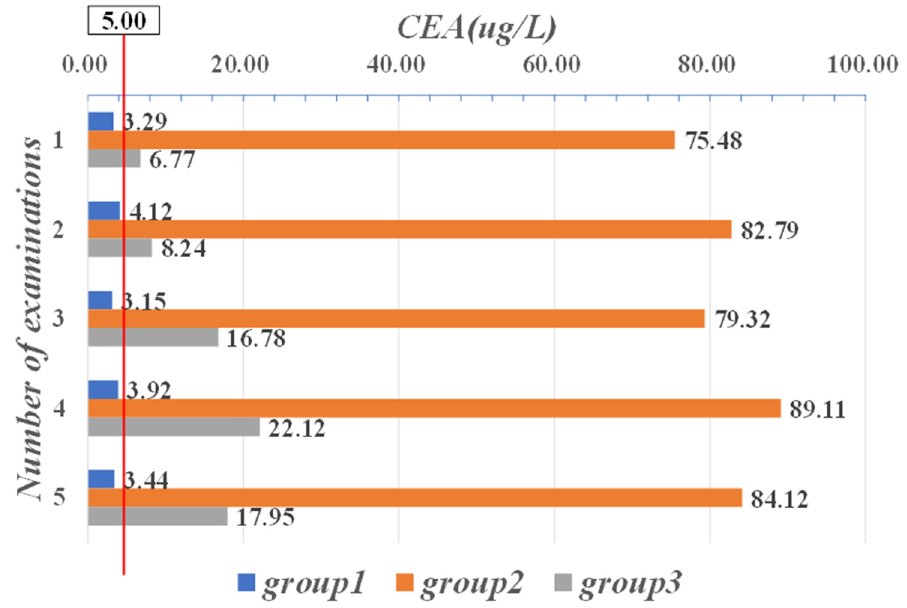
Figure 7. Mean data of five CEA examinations in three groups of